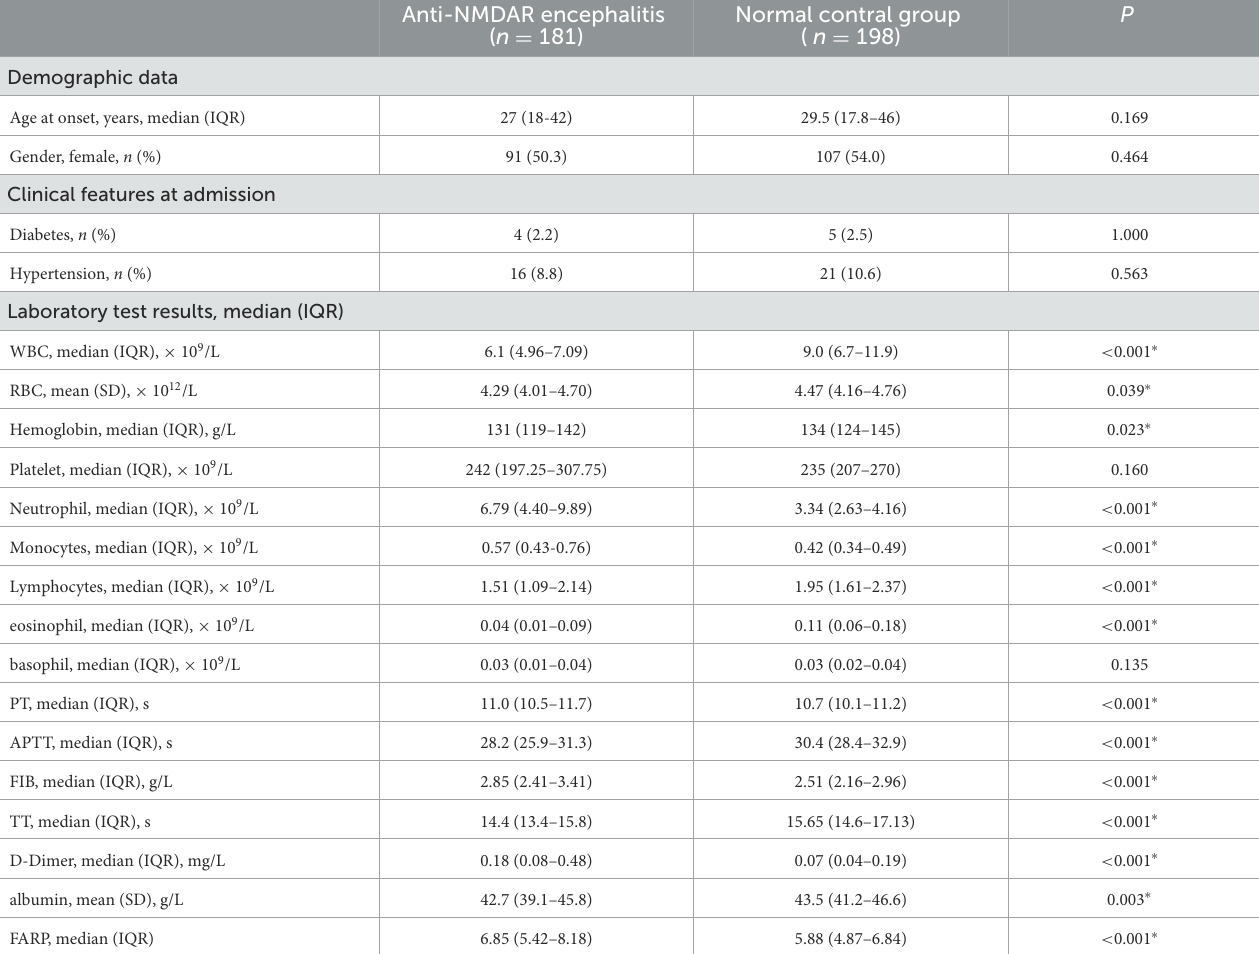
TABLE 1 Clinical characteristics of the patients with anti-NMDAR encephalitis and healthy controls.